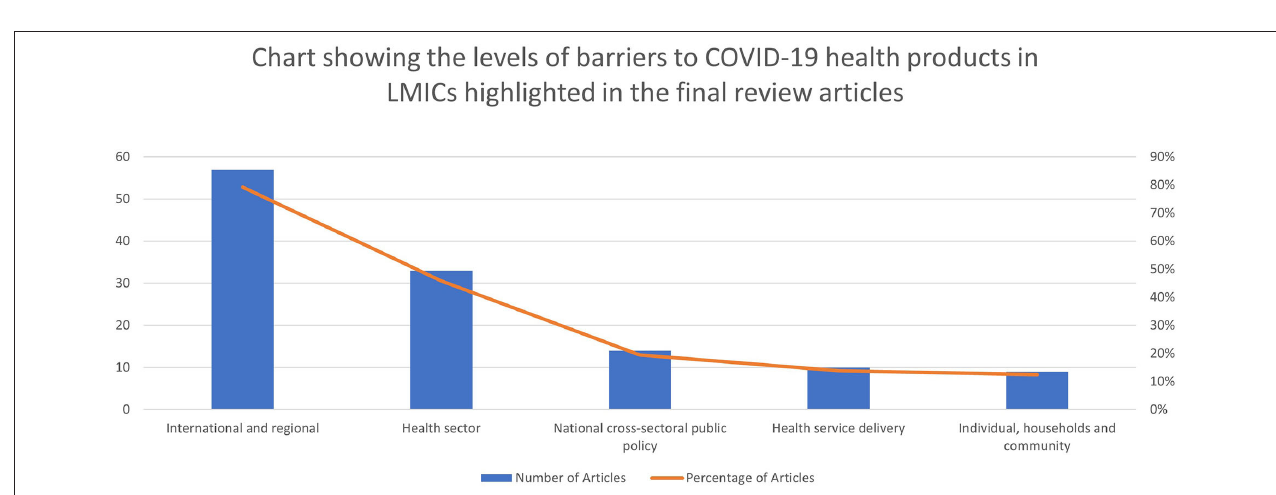
FIGURE 3 | Chart showing the barriers to COVID-19 health products in LMICs highlighted in the final review articles.